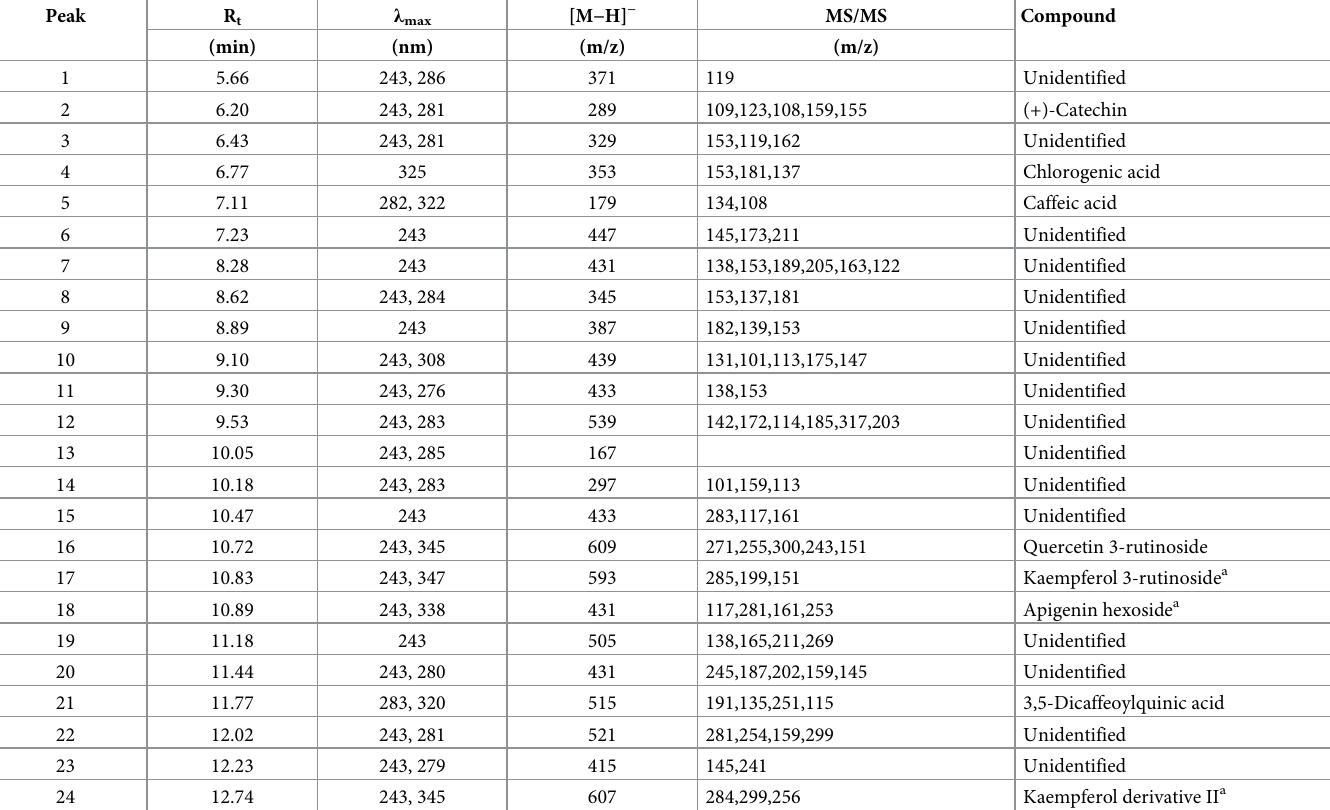
Table 3. Profile of phenolic compounds in R . squarrosus determined by UPLC-ESI-MS/MS analysis.